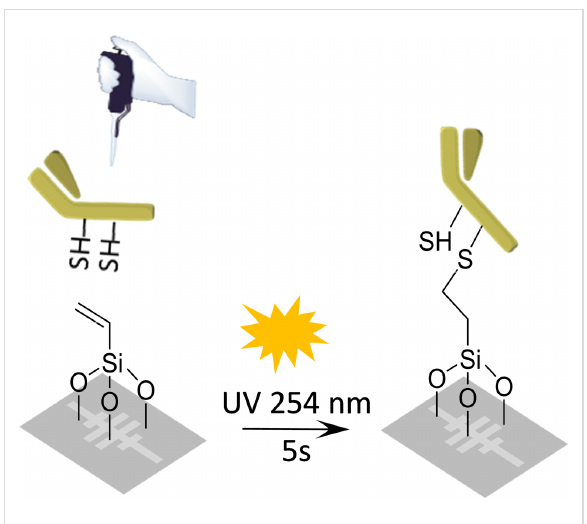
Figure 6: Schematic representation of the light-assisted immobiliza- tion of haBSA having free thiol moieties onto the vinyl-functionalized surface of the PBG sensing structures.